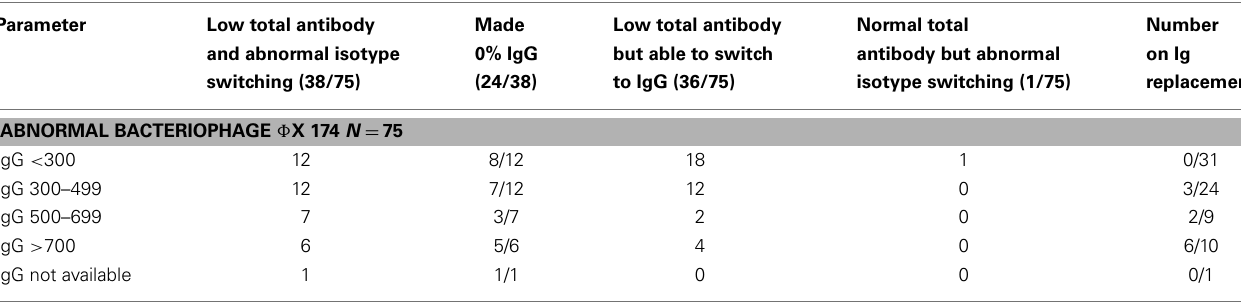
Table 4 | Isotype switching in abnormal bacteriophage patients